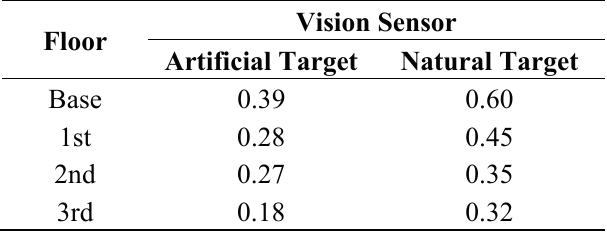
Table 3. Measurement errors: normalized root mean squared error (NRMSE)